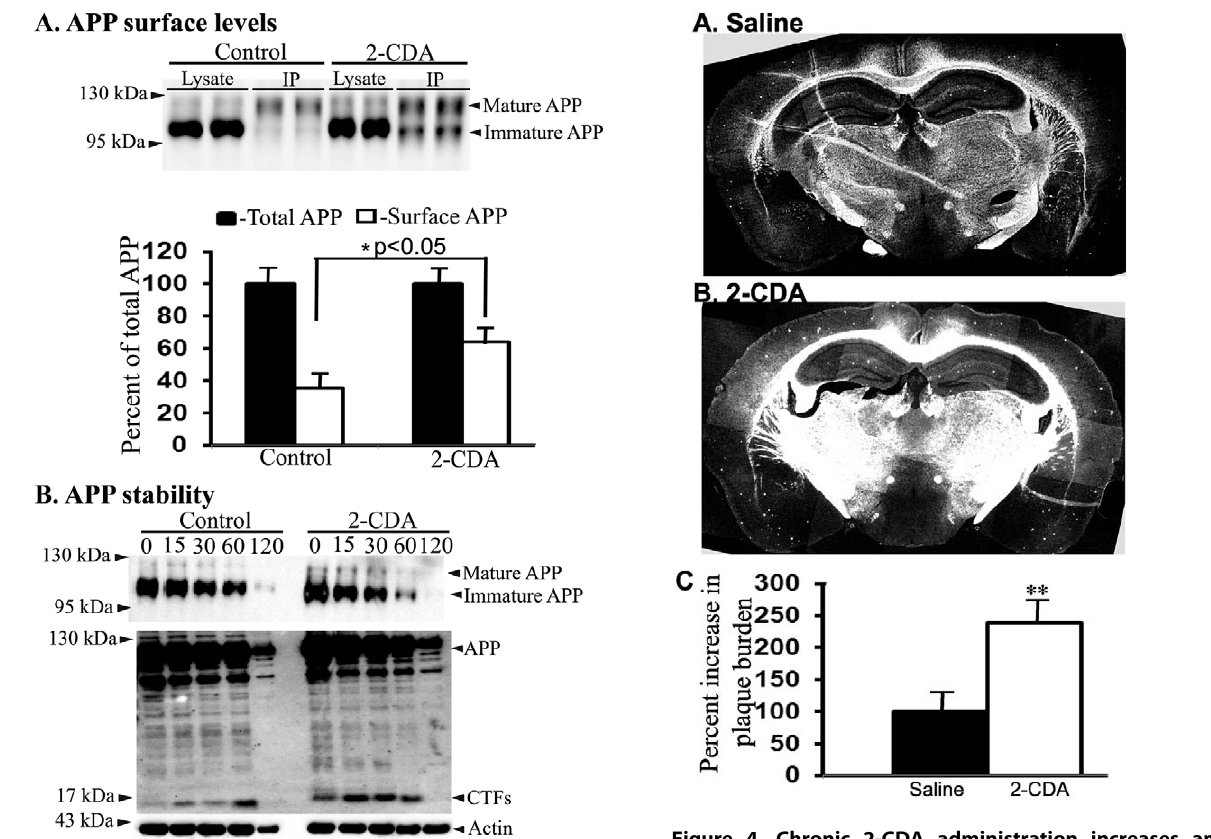
Figure 4. Chronic 2-CDA administration increases amyloid plaque burden in mice. (A) APdE9 mice were treated daily by intraperitoneal injections with 2-CDA starting from four months of age to six months of age for 60 days. Amyloid plaques were stained by Thioflavin S in coronal brain sections. A representative section with amyloid plaques in untreated mice at six months of age is shown in A. (B) a representative section of brain showing increased amyloid plaques in mice treated with 2-CDA is shown. (C) Quantitation of plaque burden by imageJ analysis showed increased burden to 240% (p , 0.01) when compared to saline treated APdE9 mice. In each group, n=4. **, p , 0.01 in 2-CDA treated APdE9 mice versus untreated APdE9 mice by student t